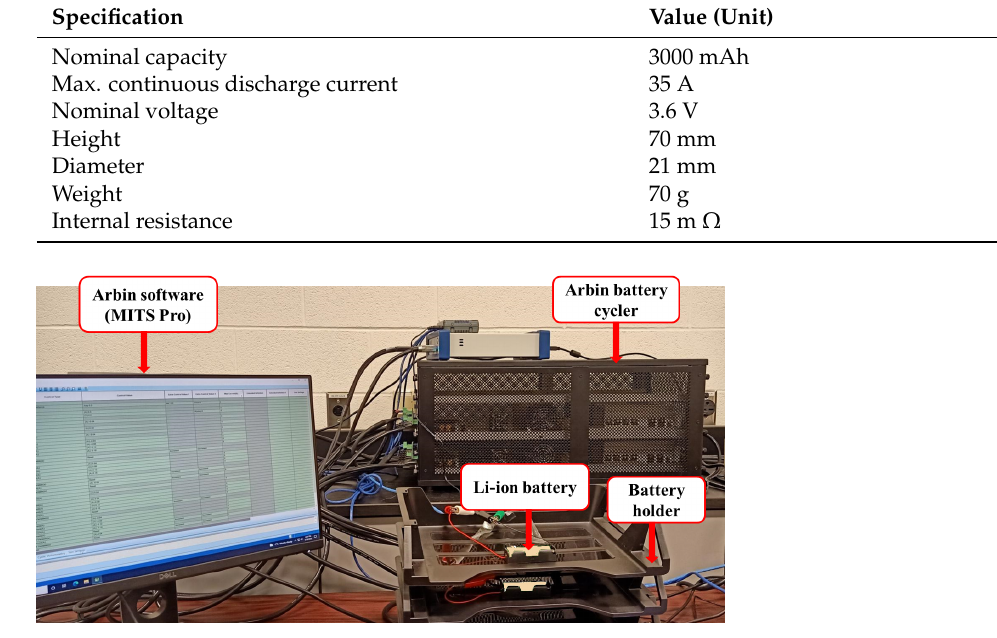
Figure 11. Experimental setup for battery